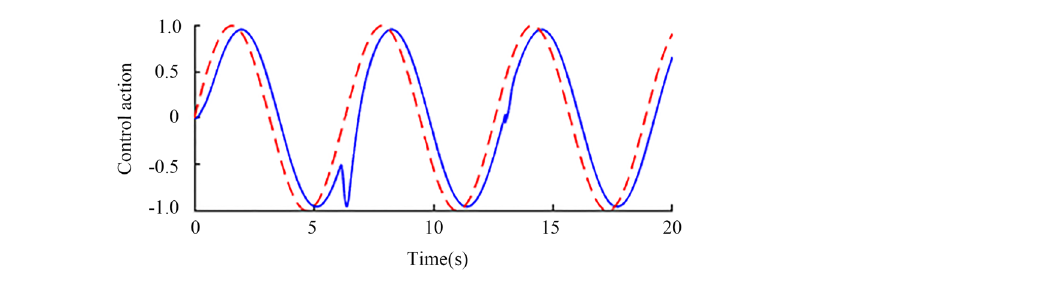
Figure 14. Nominal response when sinusoidal signal is